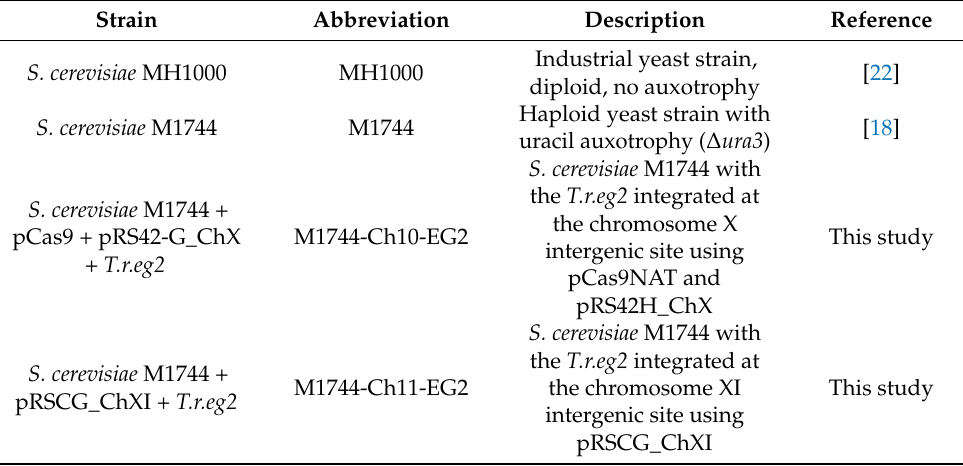
Table 2. Yeast strains used in this